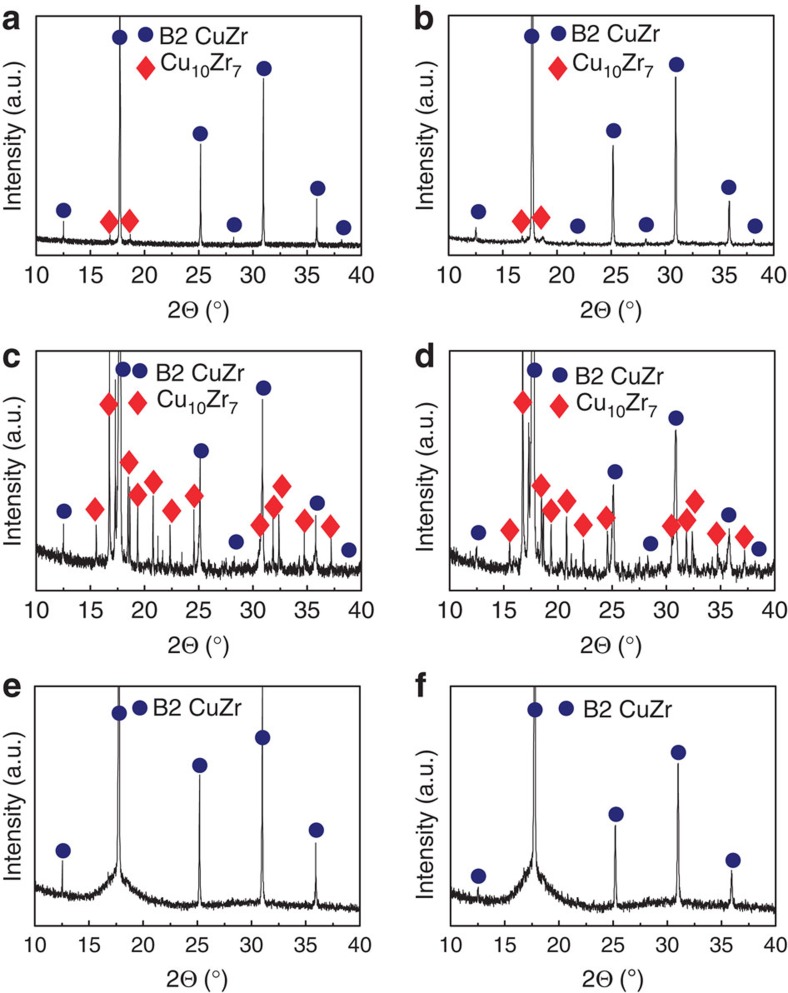
X-Ray diffraction patterns of Cu47.5Zr47.5Al5 ribbons after rapid Joule heating.Fully crystalline sample (FC-B2) (a) before and (b) after deformation. Ultrafine-structured composite (UFSC-B2) (c) before and (d) after deformation. Metallic glass-matrix composite (MG-B2) (e) before and (f) after deformation.